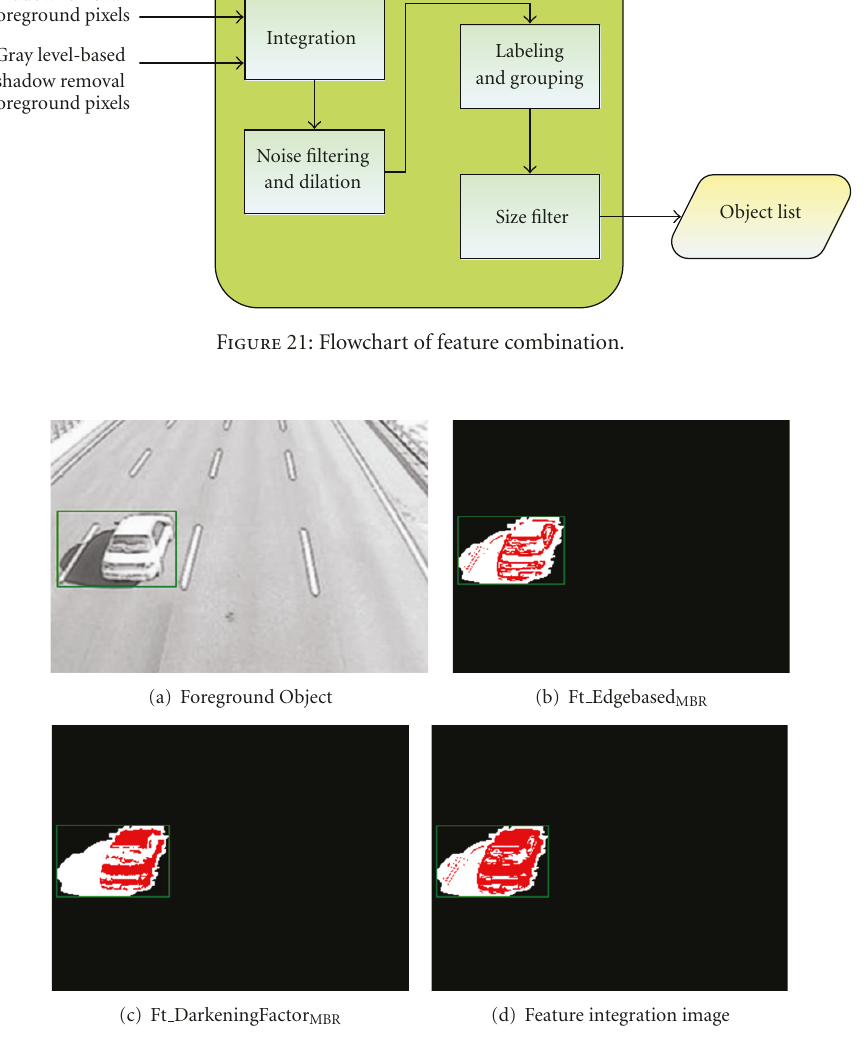
Figure 22: An example after integration.